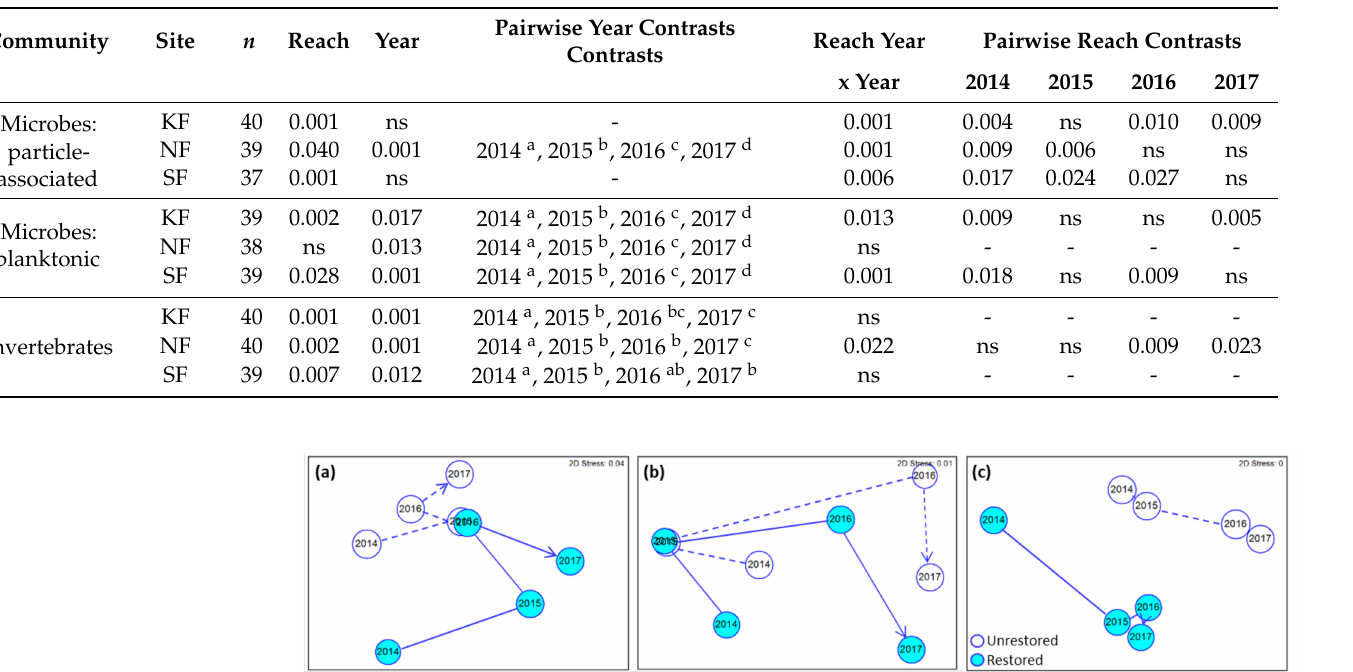
Table 2. Microbial and invertebrate PERMANOVA results for taxonomic distinctness, using partial sums of squares. Reported p -values are based on permutation of residuals under a reduced model, for main tests of reach, year, and the interaction of reach x year; KF = Kingfisher, NF = North Fork, and SF = South Fork. Where significant differences were detected in main effects, pairwise comparisons are shown by reach and year. Differences by year are indicated with superscripted letters; years with shared letters are not significantly different ( p > 0.05); “ns” indicates p > 0.05, “-” indicates no result to report. Microbial community structure is based on OTU’s; invertebrate taxonomic resolution is at the species level for fourth root-transformed data.